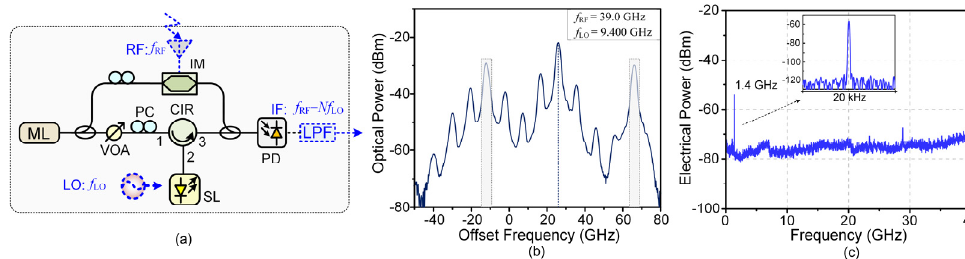
Figure 12. ( a ) Schematic of the photonic microwave harmonic down-converter; LPF: low-pass filter; ( b ) optical spectrum before photodetection; ( c ) electrical spectrum of the 1.4-GHz IF signal [63].